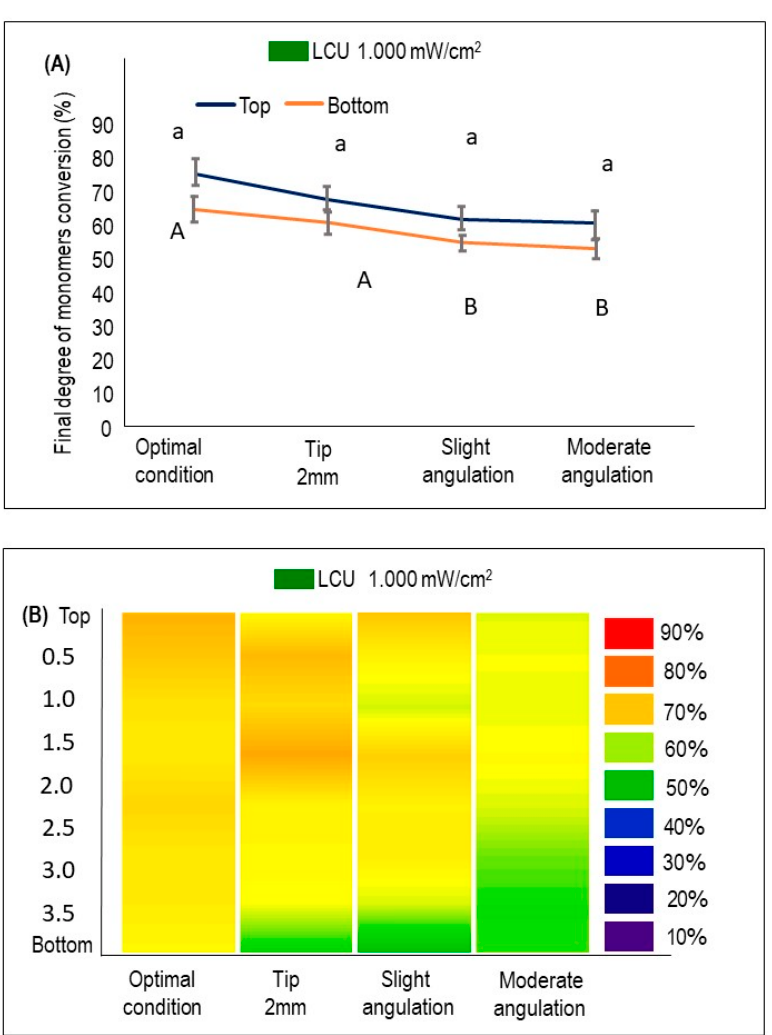
Figure 3. The %DC using LCU 1000 with an output of 1000 mW/cm 2 at the top and bottom of BF composites cured optimally or following the underperformed conditions (mean ± sd; n = 3). ( A ) The %DC values at the top and bottom of each condition. Lower case letters compare the %DC at the top of the specimen, while capital case letters compare the %DC at the bottom. Dissimilar letters are significantly different from each other ( p < 0.05). ( B ) The %DC is measured at different depths from top to bottom and visualized by the heat maps. The color bar (right) illustrates the visual representation of the %DC corresponding to the colors